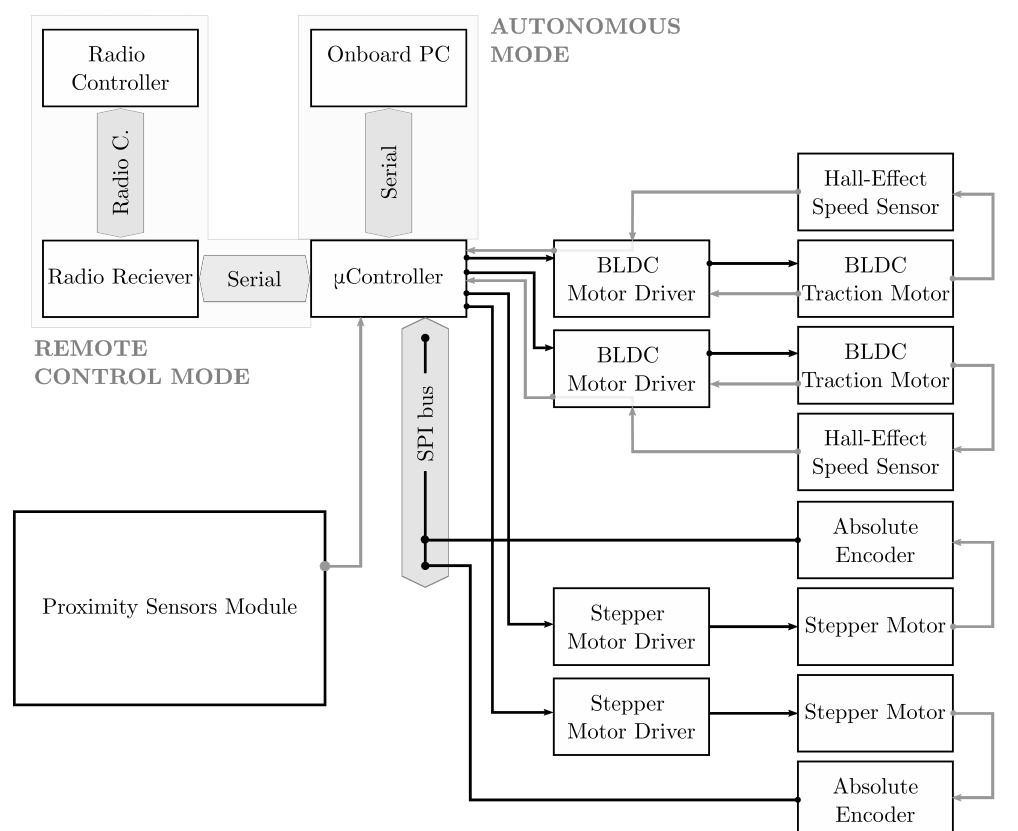
Figure 5. Schematic representation of the Low-Level Control Architecture (L-LCA).